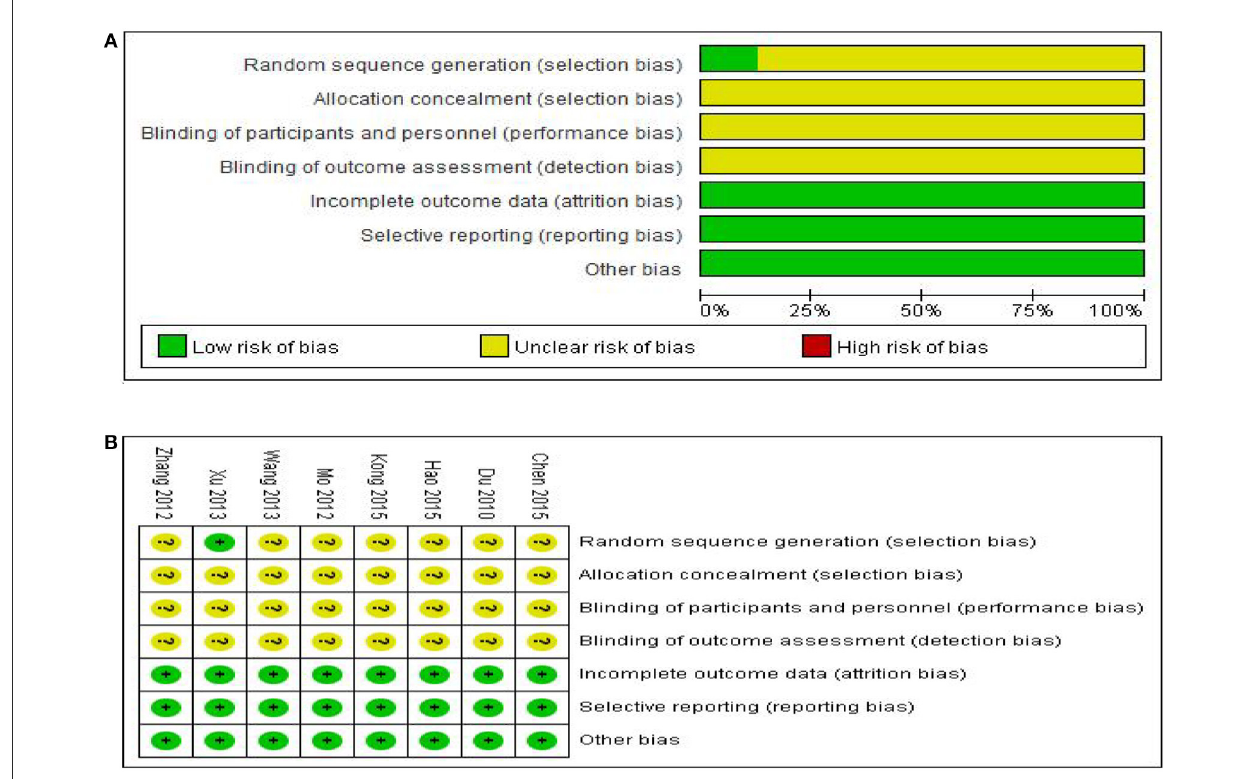
FIGURE2 Assessment of risk of bias in the eight trials. (A) Risk bias results proportional chart, (B) Summary chart of risk bias results.